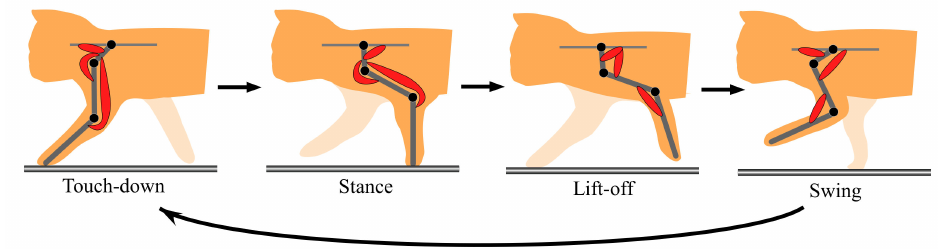
Figure 4. Cycle of the four leg phases (touchdown, stance, liftoff, and swing).